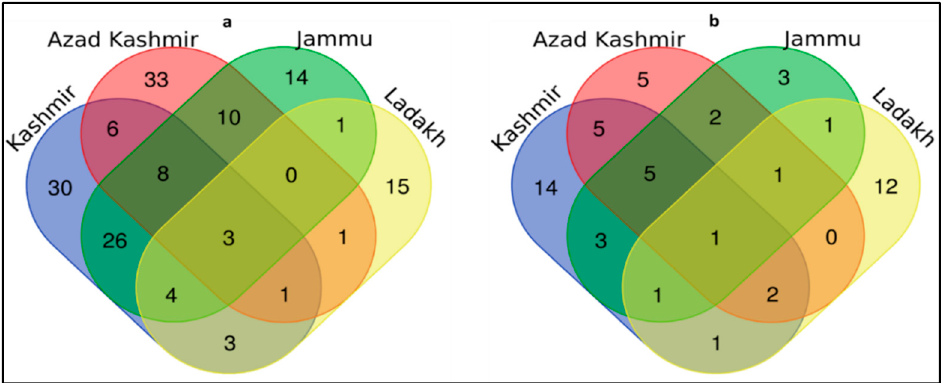
Figure 7. Venn diagram ( a ) representing unique and common plant species ( b ) representing unique and common animal species among different regions.